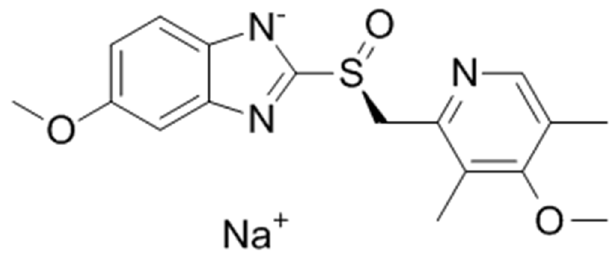
Figure 1. Esomeprazole sodium (sodium 5-methoxy-2-[(S)-(4-methoxy-3,5-dimethylpyridin-2- yl)methanesulfinyl]-1H-1,3-benzodiazol-1-ide).